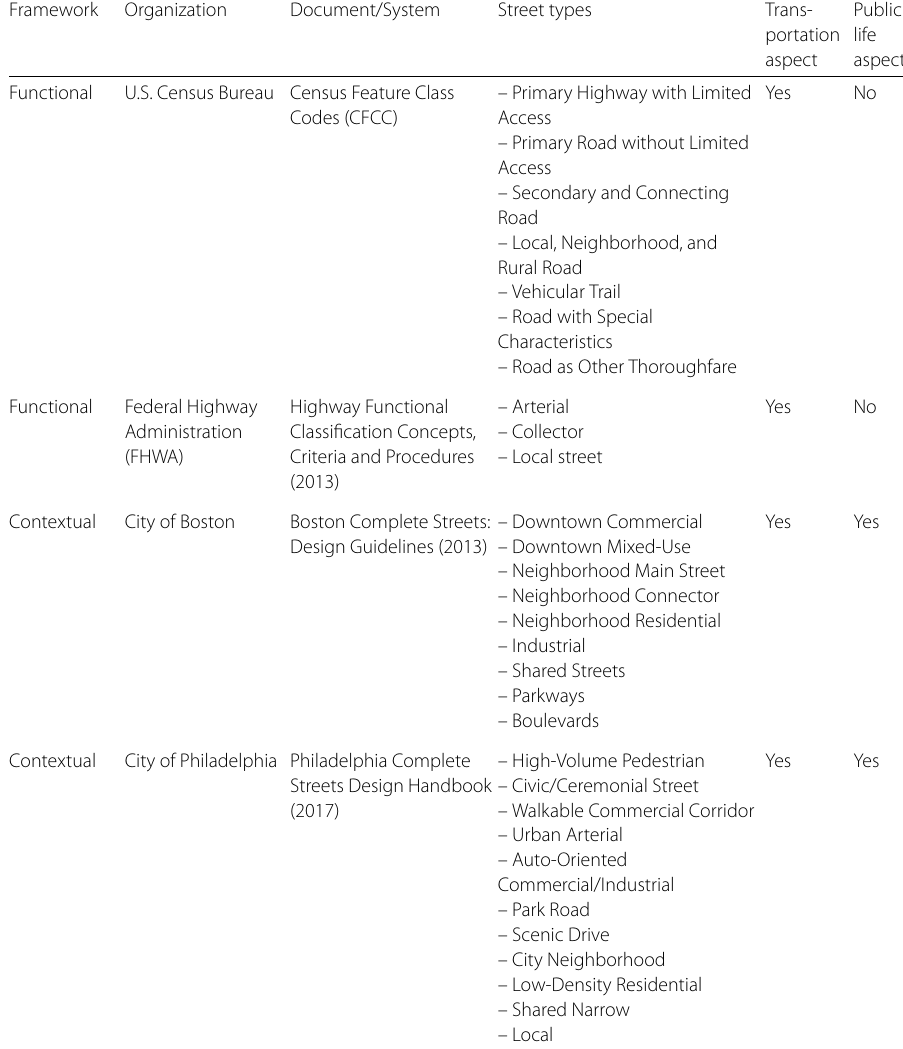
Table 1 Functional and contextual street classification